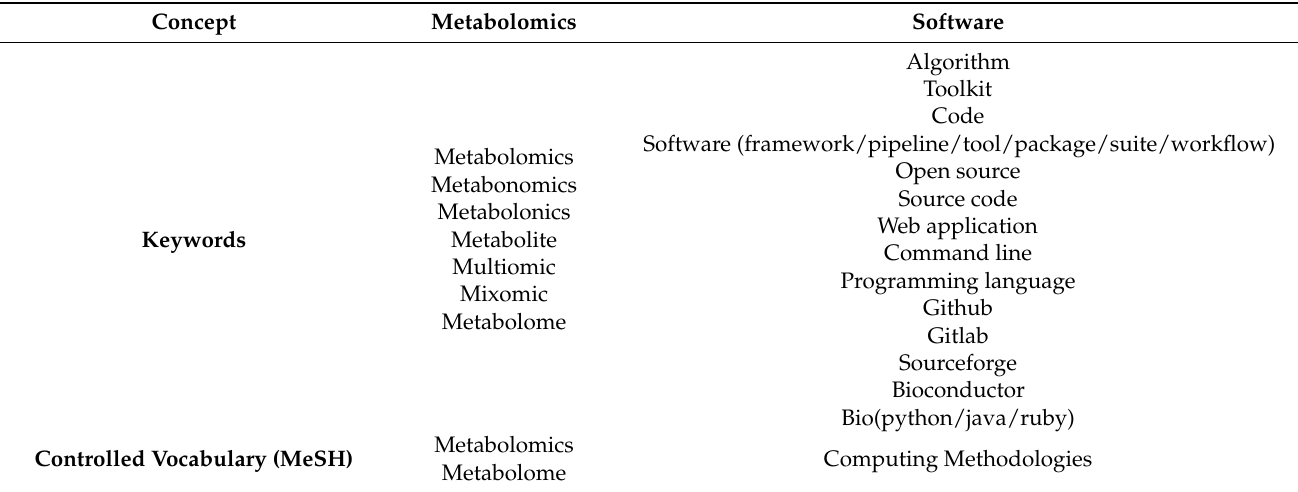
Table 4. Outline of second PubMed query to obtain metabolomics software tools papers based on metabolomics and software-related keywords and MeSH